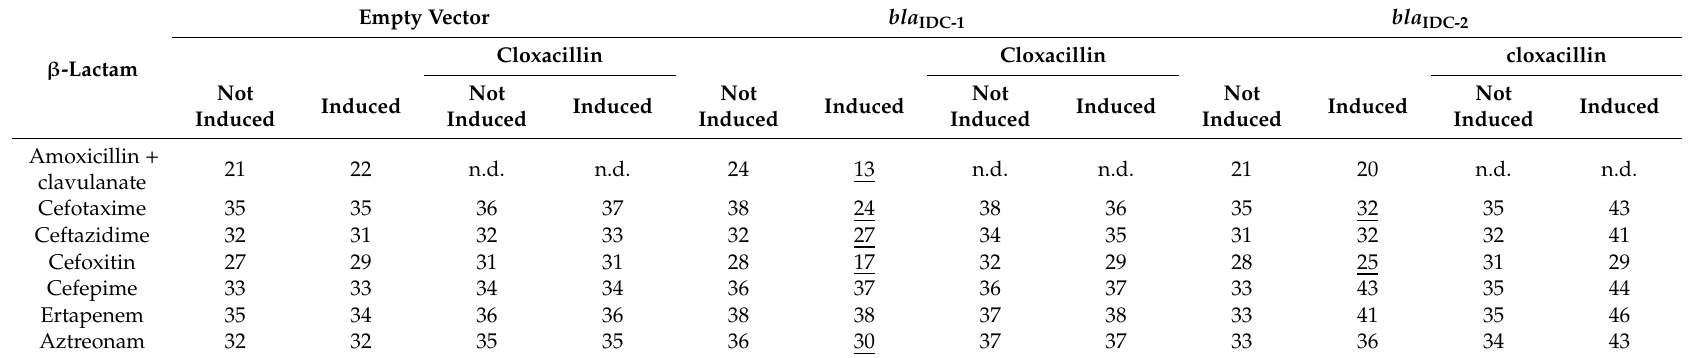
Table 1. Resistance profile of bla IDC-1 and bla IDC-2 (disk di ff usion).